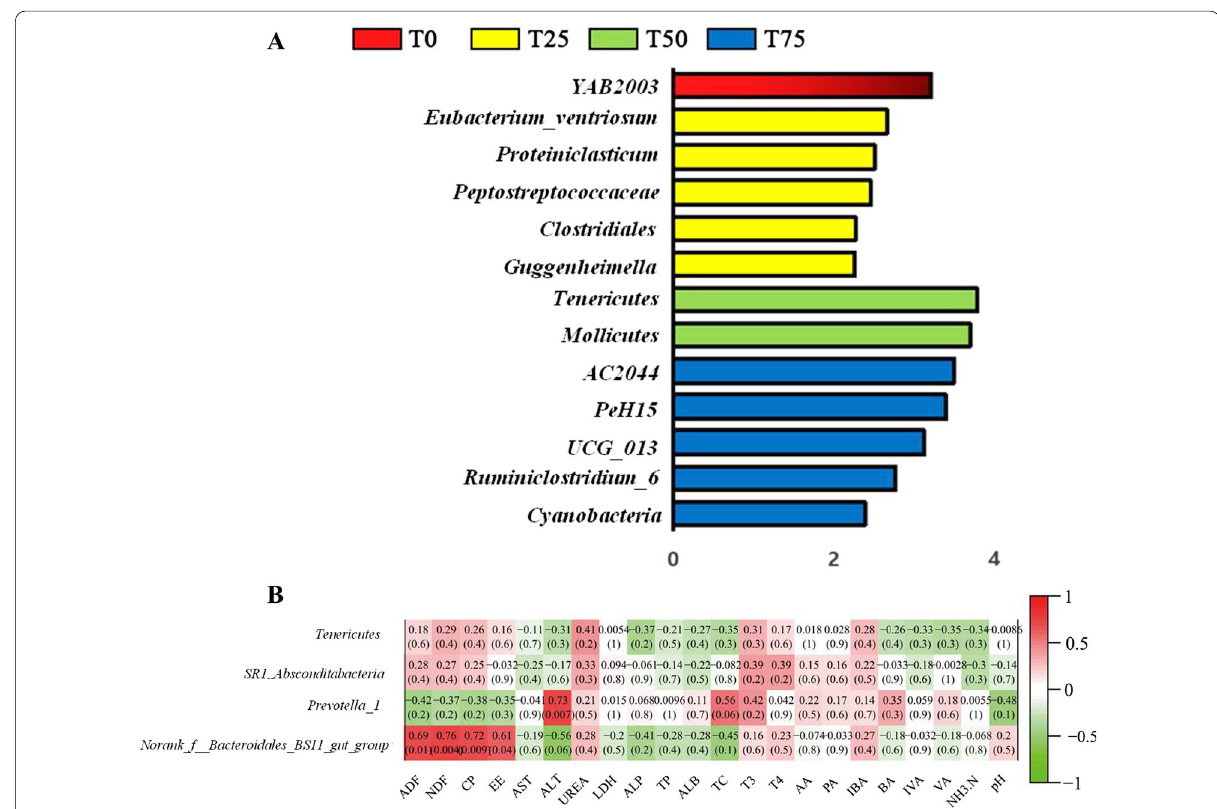
Fig. 3 The LDA Effect Size analysis (LEfSe) A of Holstein heifers in T0, T25, T50 and T75 group. B Correlation between the statistically different bacteria at the genus and digestibility/rumen fermentation parameters/serum biochemical